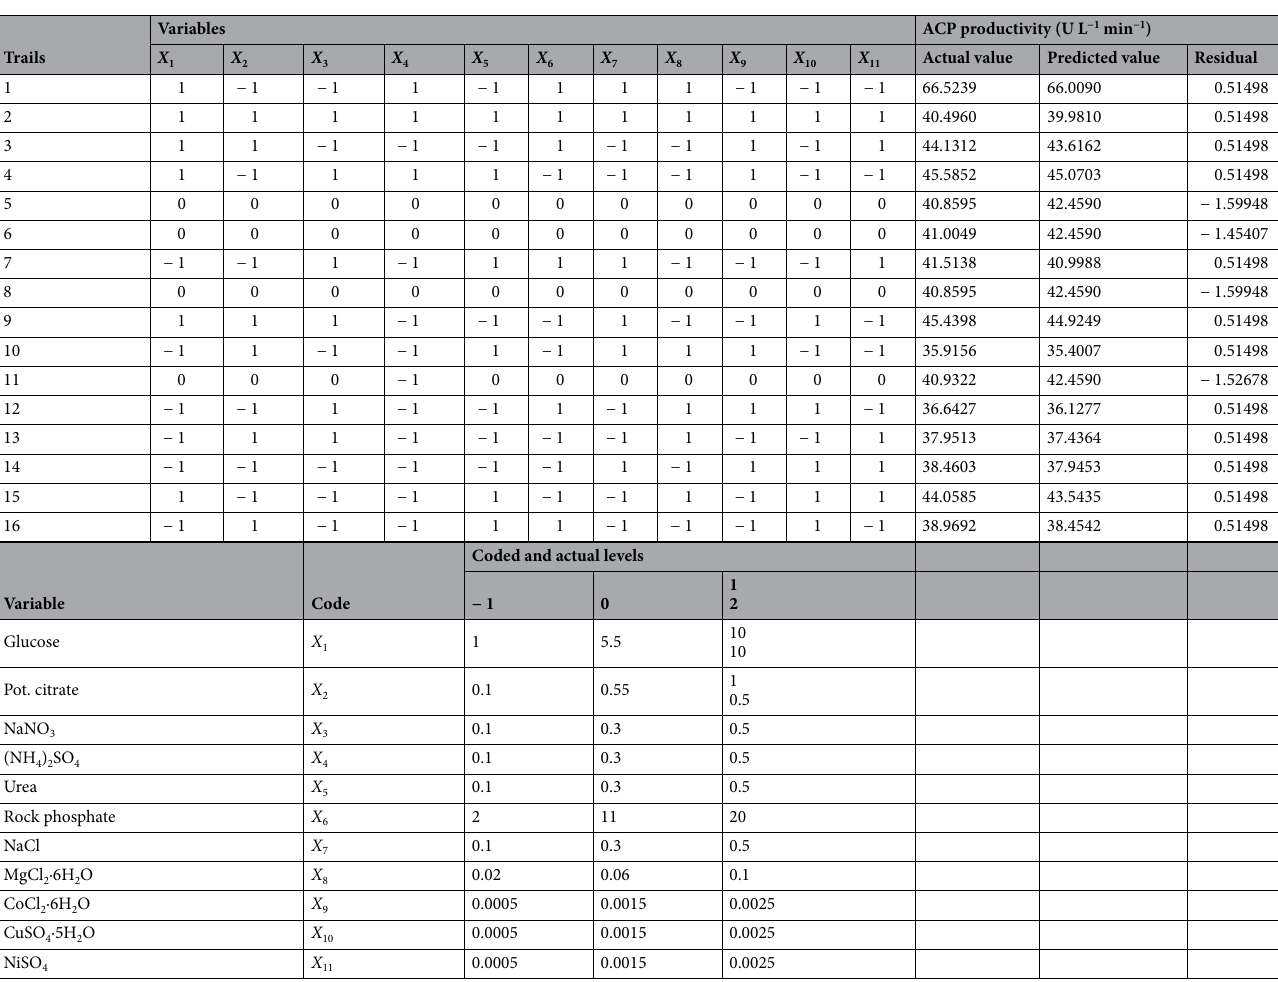
Table 1. Randomized Plackett–Burman experimental design for evaluating factors influencing ACP production by B. haynesii strain ACP1.